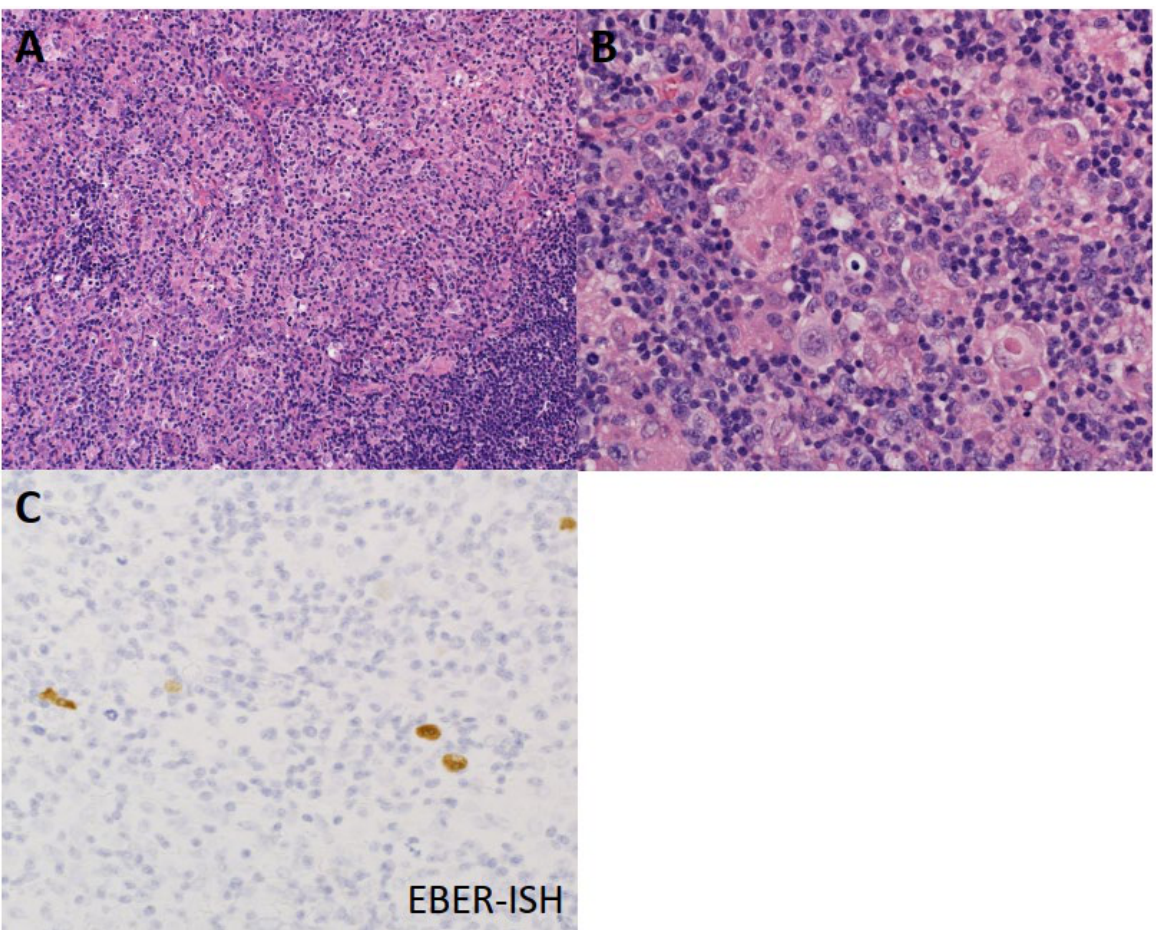
Figure 2. Histological features of mixed cellularity classical Hodgkin lymphoma (MCCHL). ( A ) Granuloma formation by histiocyte aggregation is observed in the background. ( B ) Neoplastic cells are scattered against a background rich in histiocytes and lymphocytes. ( C ) Neoplastic cells with highlighted Epstein–Barr virus RNA through in situ hybridization